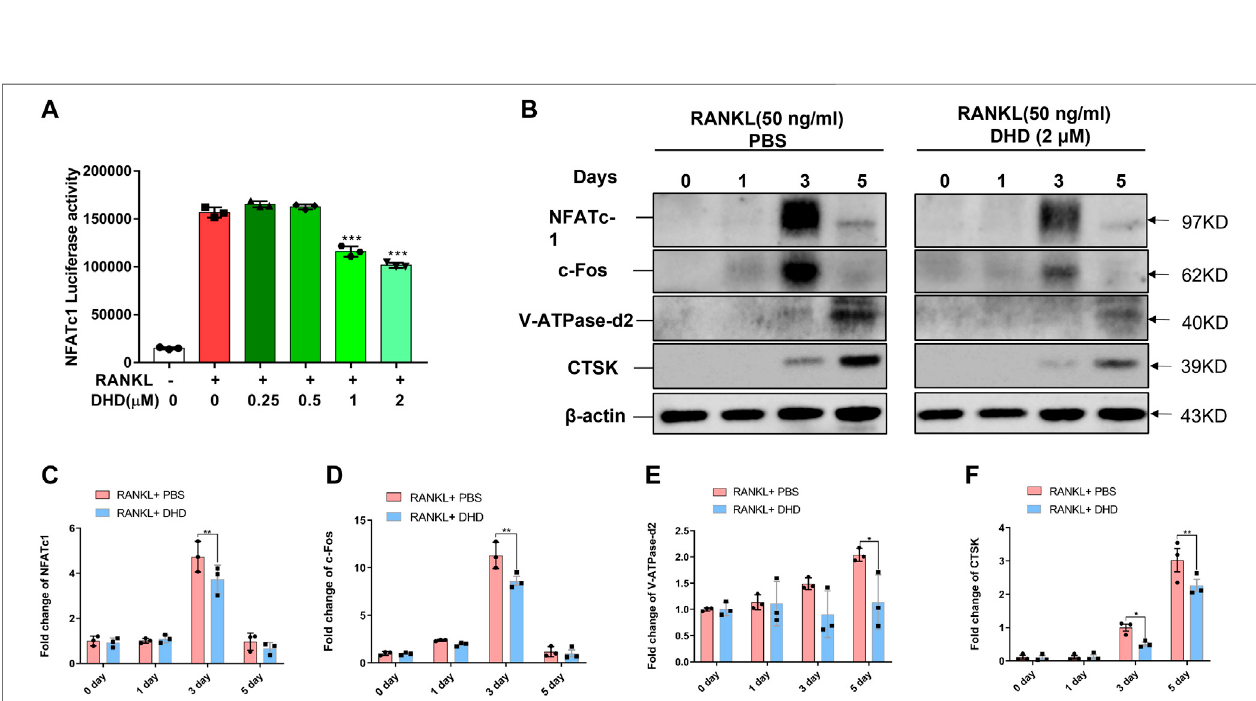
FIGURE 6 | DHD represses NFATc1 activity and downstream protein expression. (A) Bar graph depicting luciferase activity of RAW264.7 cells stably transfected with the NFATc1 luciferase reporter construct. (B) Representative Western blotting images of NFATc1, c-Fos, V-ATPase-d2, and CTSK on days 0, 1, 3, and 5 after stimulation by RANKL (50 ng/ml) with or without DHD (2 μ M). (C – F) The intensity of the band for all the proteins mentioned above was calculated as a ratio to β -actin.